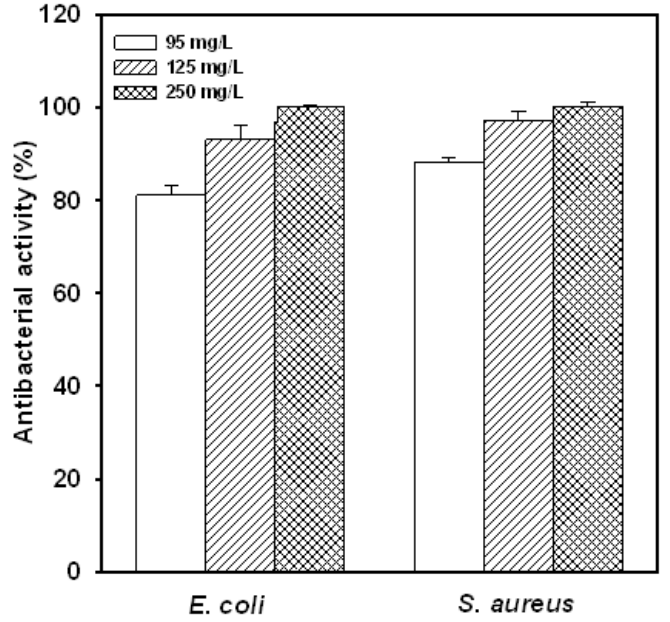
Figure 1. Effect of different concentration of water-soluble chitosan derivative (GN 70-3) on the antibacterial activity of E. coli and S. aureus for 6 h at 37 °C in nutrient broth. The initial cell number was 10 7 CFU/mL. Each value is expressed as mean ± SD (n =